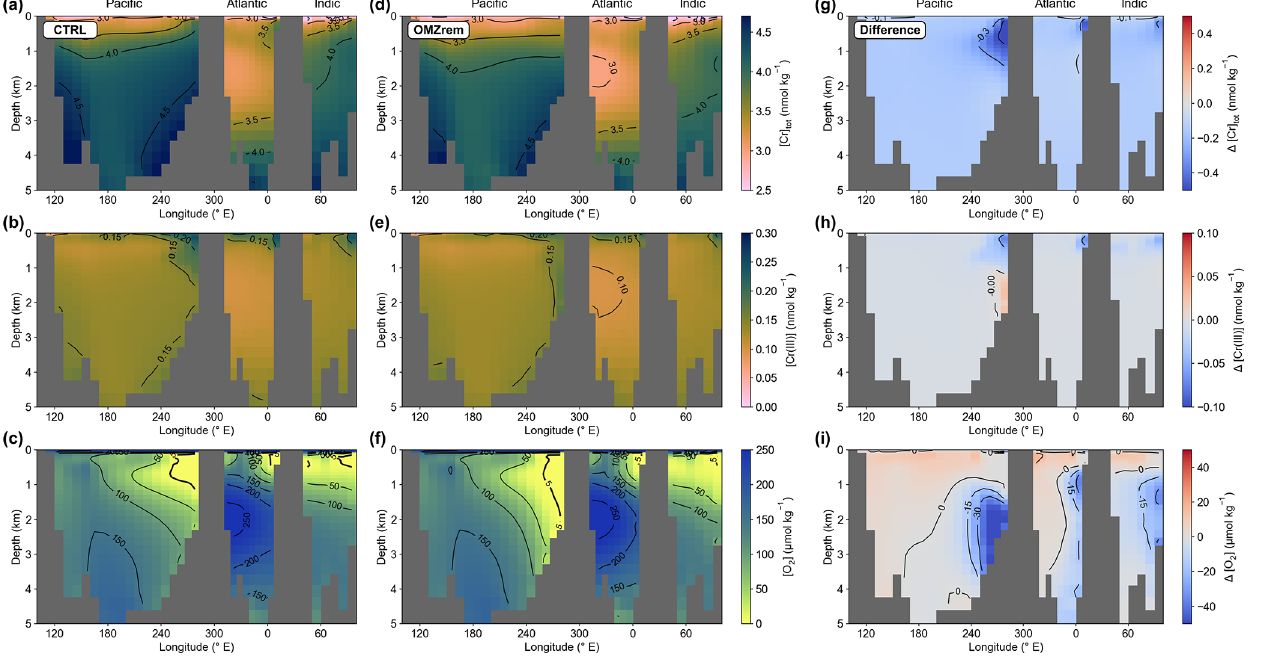
higher OMZ reduction rates, together with the O 2 -dependent remineralization, do indeed provide an improved represen- tation of OMZ Cr concentration characteristics (Cr(III) and Cr tot ) consistent with observations (see Moos et al., 2020; Rue et al., 1997). However, it is worthy of note that observa- tions indicate that the Cr(III) maximum in OMZ depth pro- files is shifted toward shallower depths (Huang et al., 2021; Rue et al., 1997) and not in the middle or bottom of the OMZ